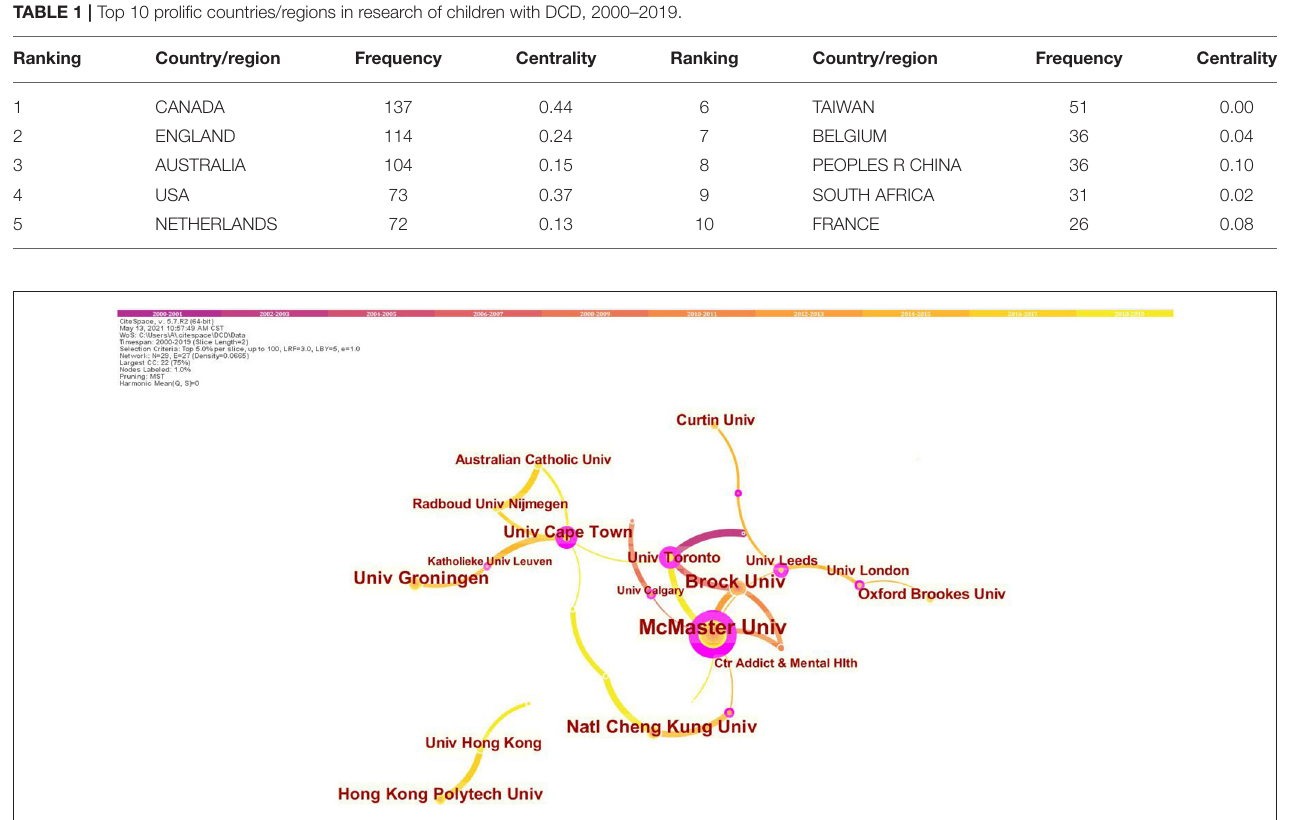
FIGURE 3 | Map of institutes’ cooperative relations in research of children with DCD, 2000–2019. The bigger the circle, the more original articles the institute published. The shorter and thicker the connection line, the closer the relationship.